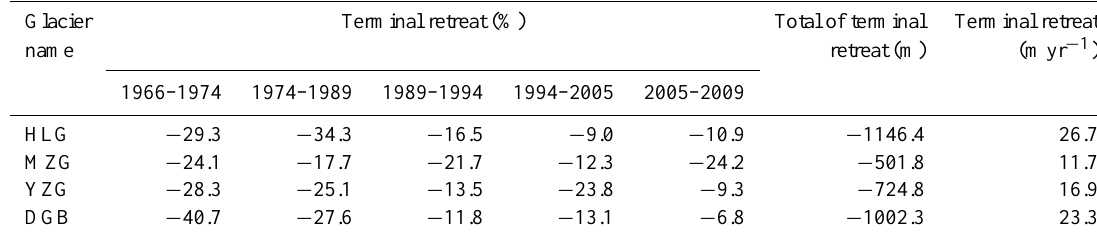
Table 5. Terminal retreat of four typical glaciers. Glacier Terminal retreat (%) Total of terminal Terminal